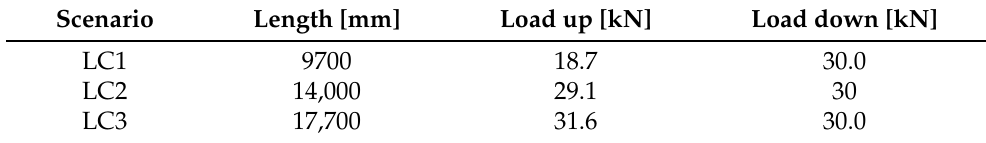
Table 2. Loads applied by load cells and load frame positions for all the torsion load